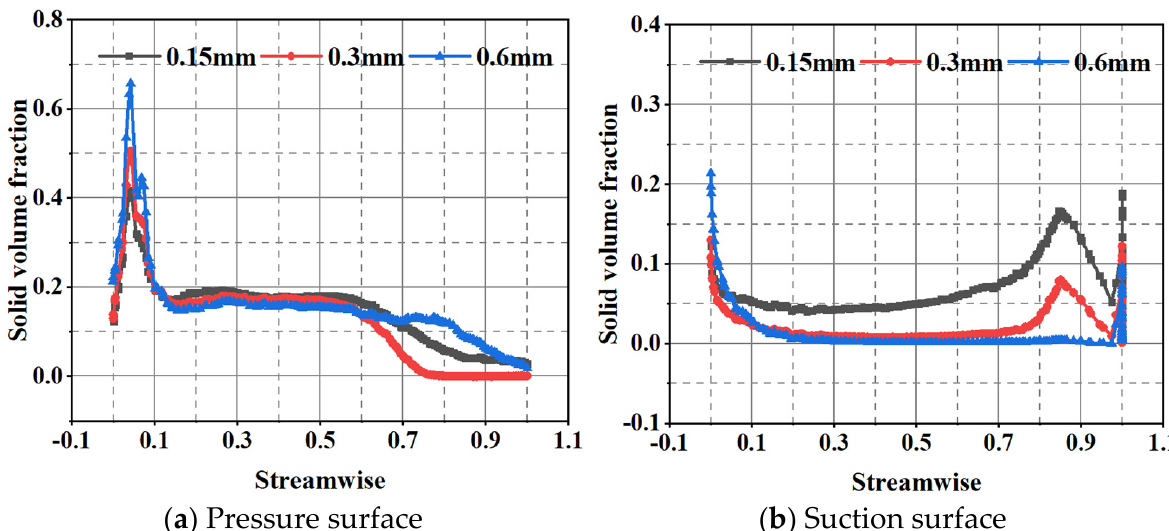
Figure 14. ( a , b ) Solid volume fraction distribution of blade.